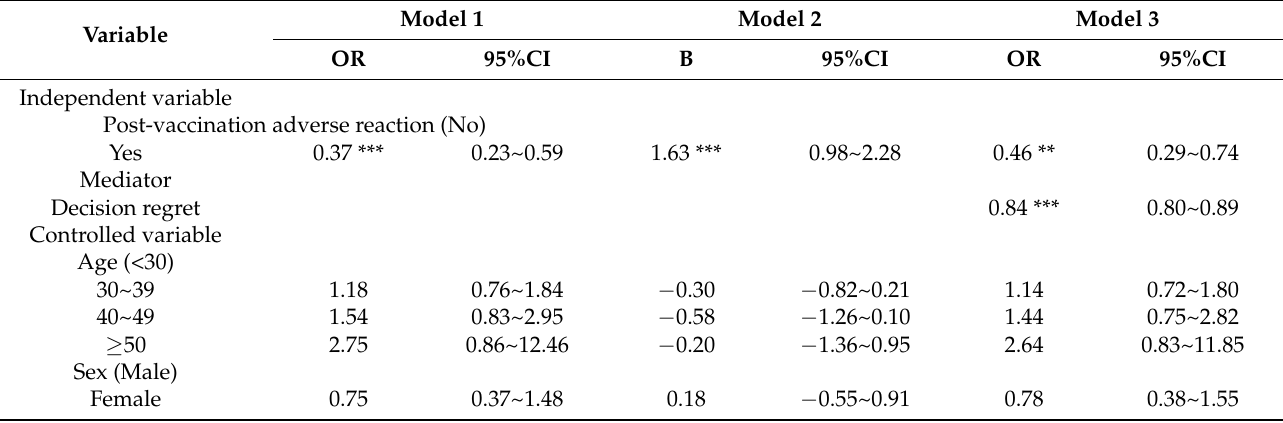
Table 4. Testing of the mediating role of decision